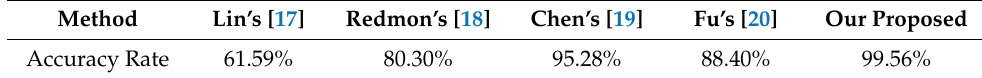
Table 3. Accuracy comparison results of different methods.